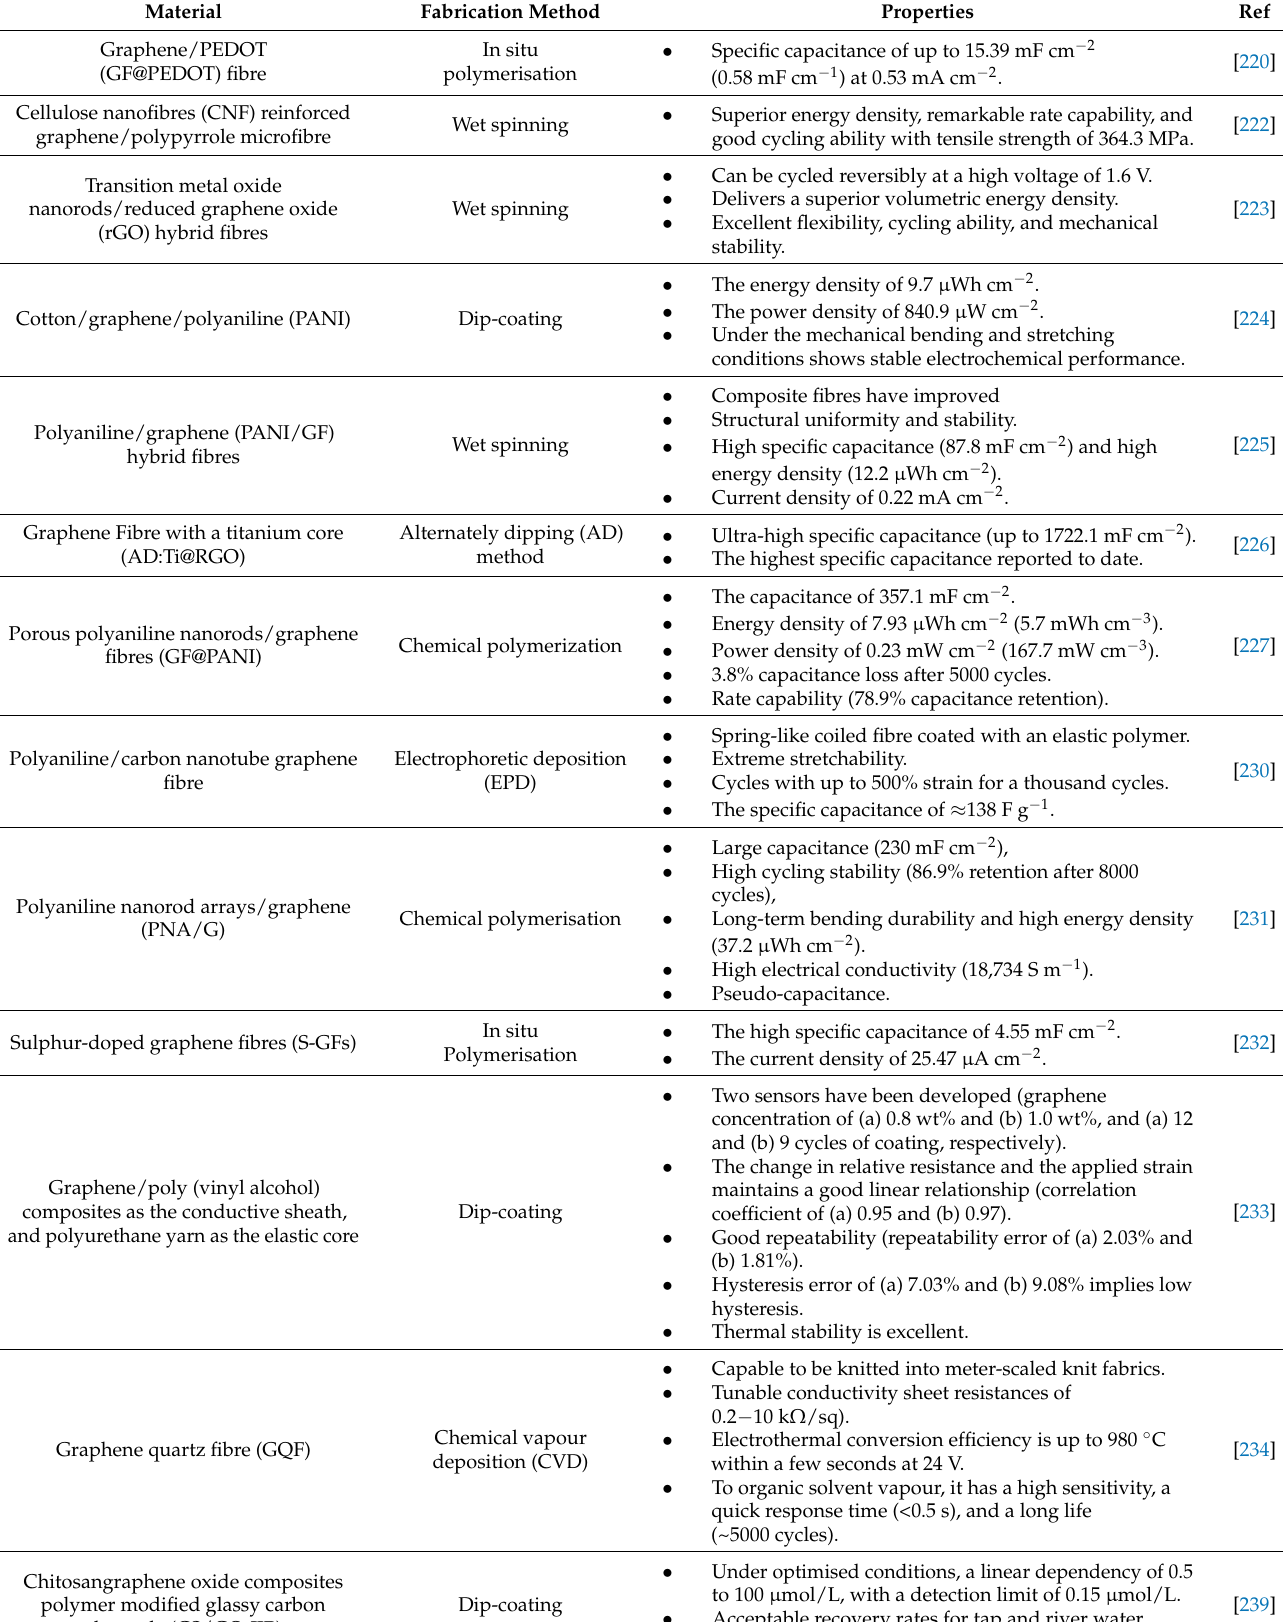
Table 4. Fabrication and properties of graphene-based materials used in wearable